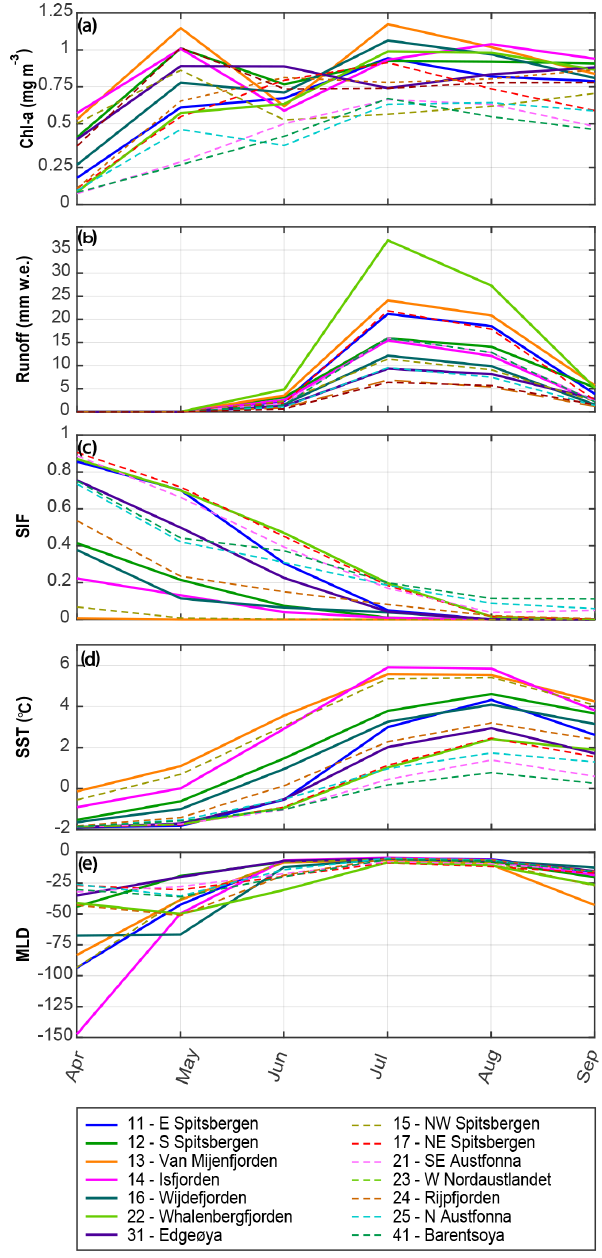
Figure 3. Average evolution of monthly variables for all primary hydrological regions and associated marine areas within 10km dis- tance from the coast: (a) chlorophyll a concentration, CHL; (b) spe- cific glacier runoff, RUNOFF, per marine area; (c) sea-ice fraction, SIF; (d) sea-surface temperature, SST; and (e) mixed-layer depth, MLD. Solid lines represent regions that exhibit a significant pos- itive correlation between RUNOFF and CHL (a) , whereas dashed lines represent regions where no significant correlation was